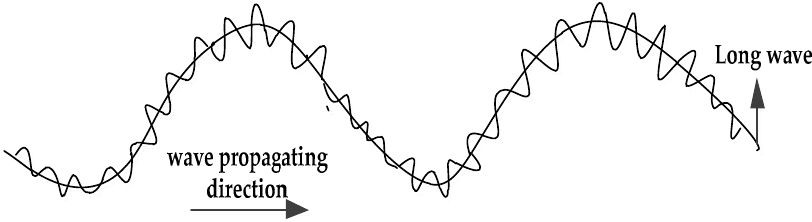
Figure 5. Scattering mechanism of the two-scale model.